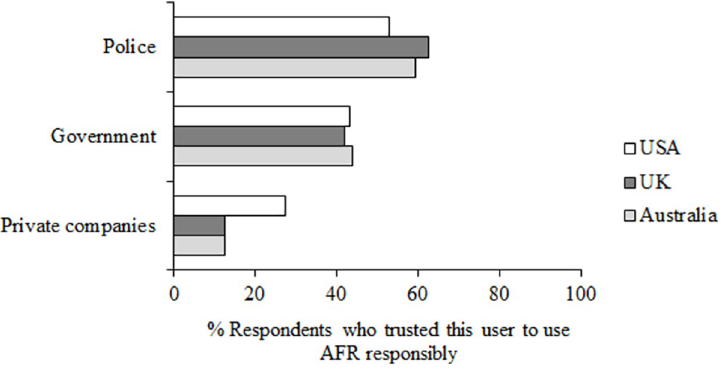
Fig 8. Questions 10–12 data. Percent of participants who trust (responding 4, 5 or 6 on the scale of trust) these users to use AFR responsibly, responding to the questions 10–12 “To what extent do you trust the police/the government/ private companies in your country to use facial recognition technology